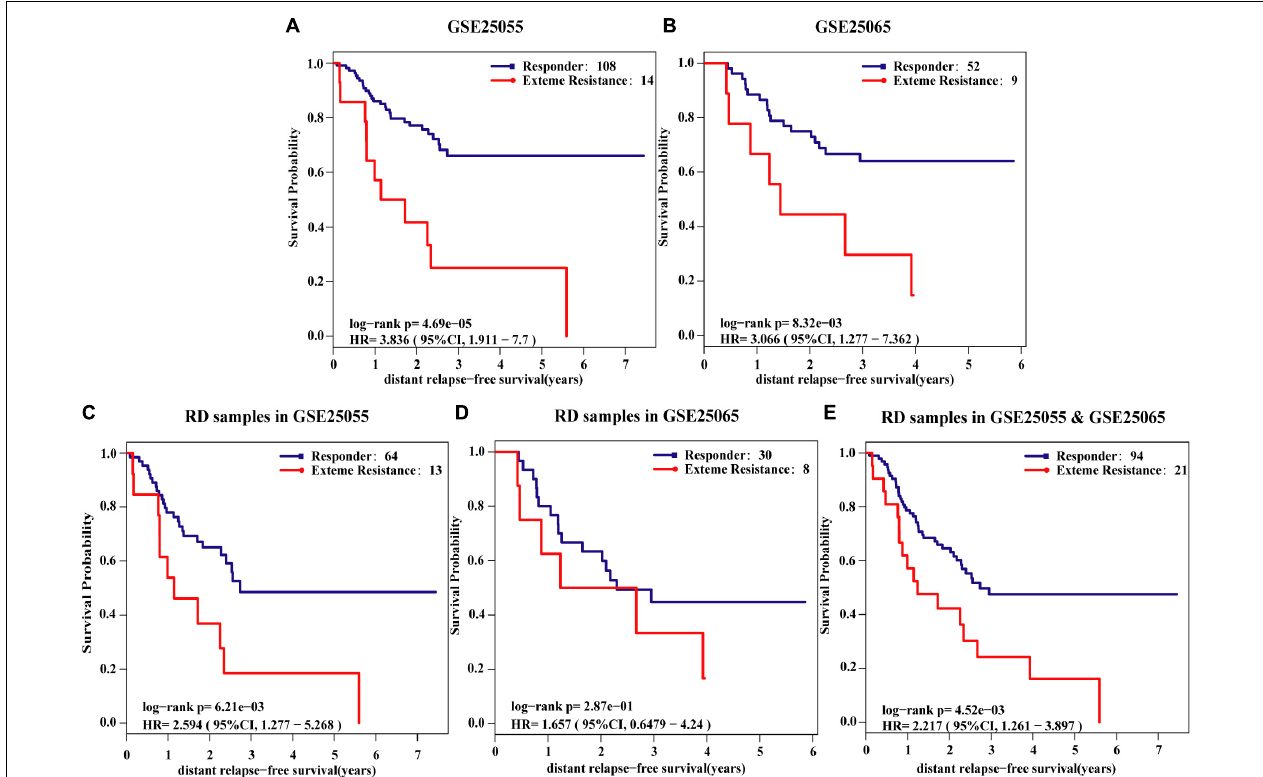
FIGURE 2 | Kaplan–Meier estimates of distant relapse-free survival (DRFS). DRFS curves for responder and extreme resistance in (A) GSE25055; (B) GSE25065; (C) RD samples of GSE25055; (D) RD samples of GSE25065; (E) integrated RD samples of GSE25055 and